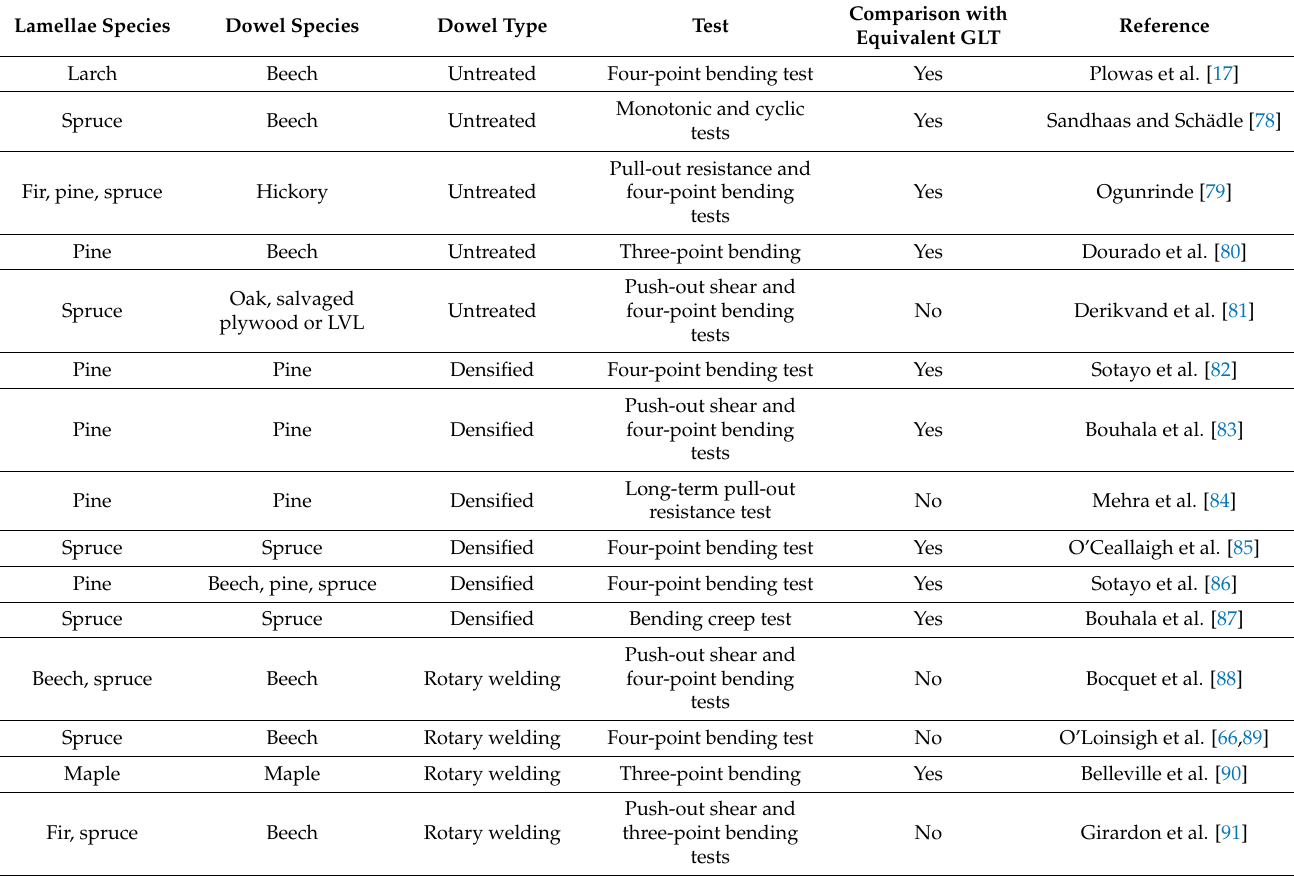
Table 1. Summary literature data on dowel laminated timber (DLT) panels and beams.